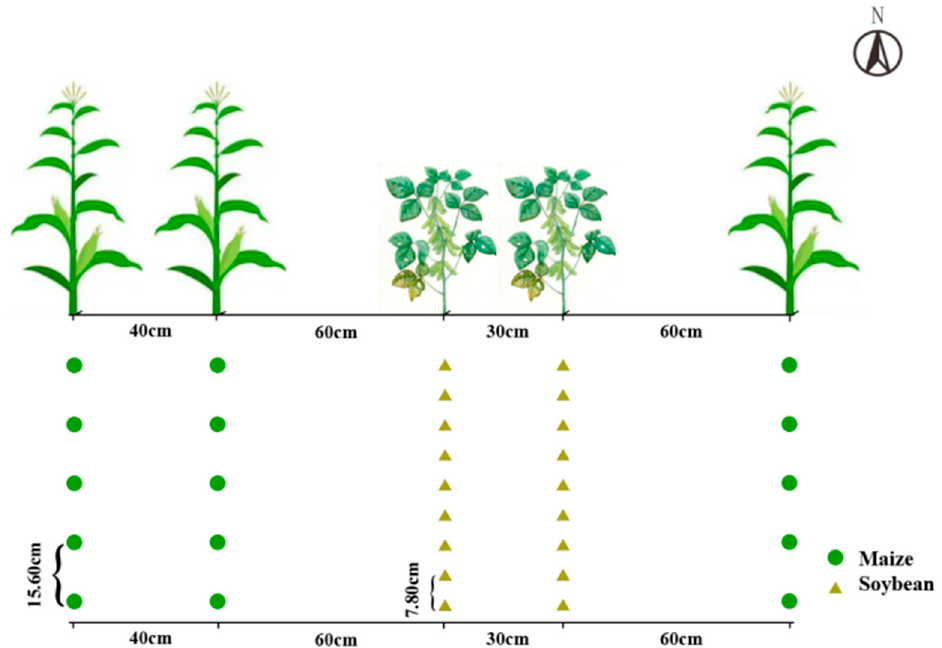
Figure 1. Pattern of maize–soybean intercropping: The row ratio of maize–soybean intercropping was 2:2; the spacing between maize rows, soybean rows, and maize–soybean rows was 40 cm, 30 cm, and 60 cm, respectively. The maize plant spacing was 15.80 cm, and the soybean plant spacing was 7.80 cm.